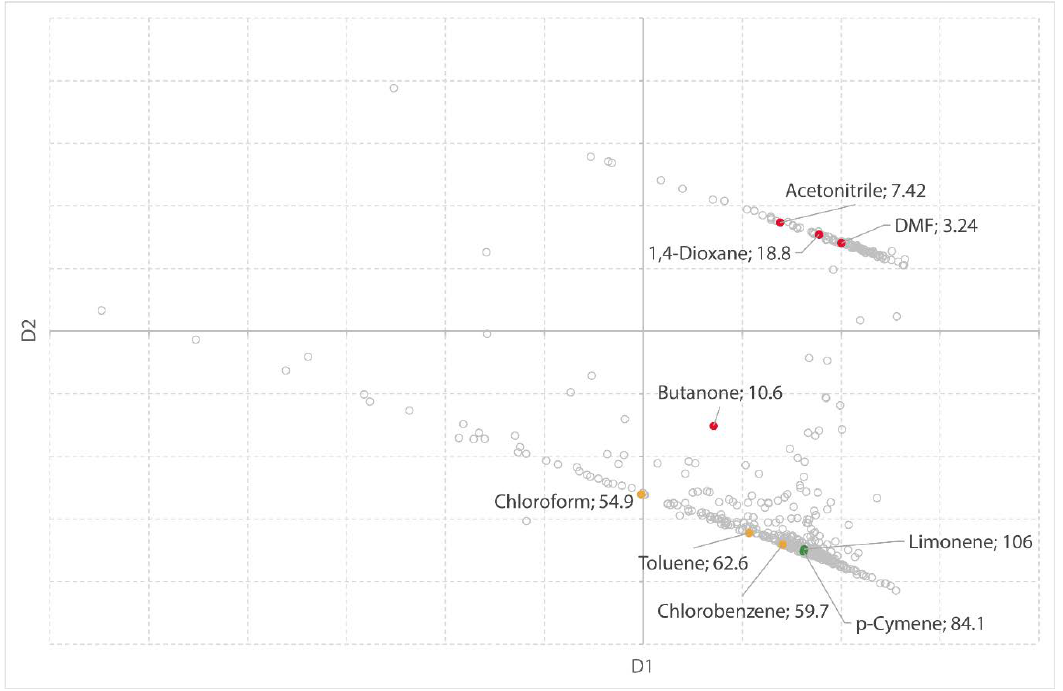
Figure 7. The synthesis of butyl butanoate from butanoic anhydride and 1-butanol. Molecules 2020 , 25 , x FOR PEER REVIEW